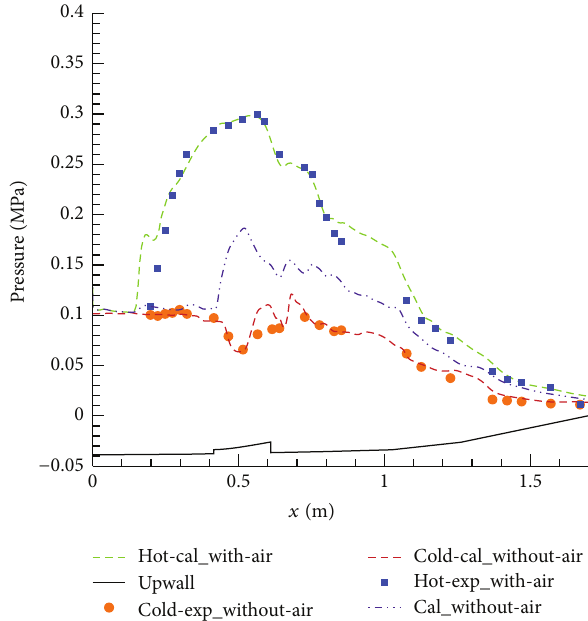
Figure 10: Wall pressure of the experiment and calculation with and without air throttling (hot-cal with-air: calculation result of chemical reaction flow with air throttling; upwall: the up wall of the scramjet combustor; cold-exp without-air: experimental result of nonreaction flow without air throttling; cold-cal without-air: calculation result of nonreaction flow without air throttling; hot- exp with-air: experimental result of chemical reaction flow with air throttling; hot-cal without-air: calculation result of chemical reaction flow without air throttling).